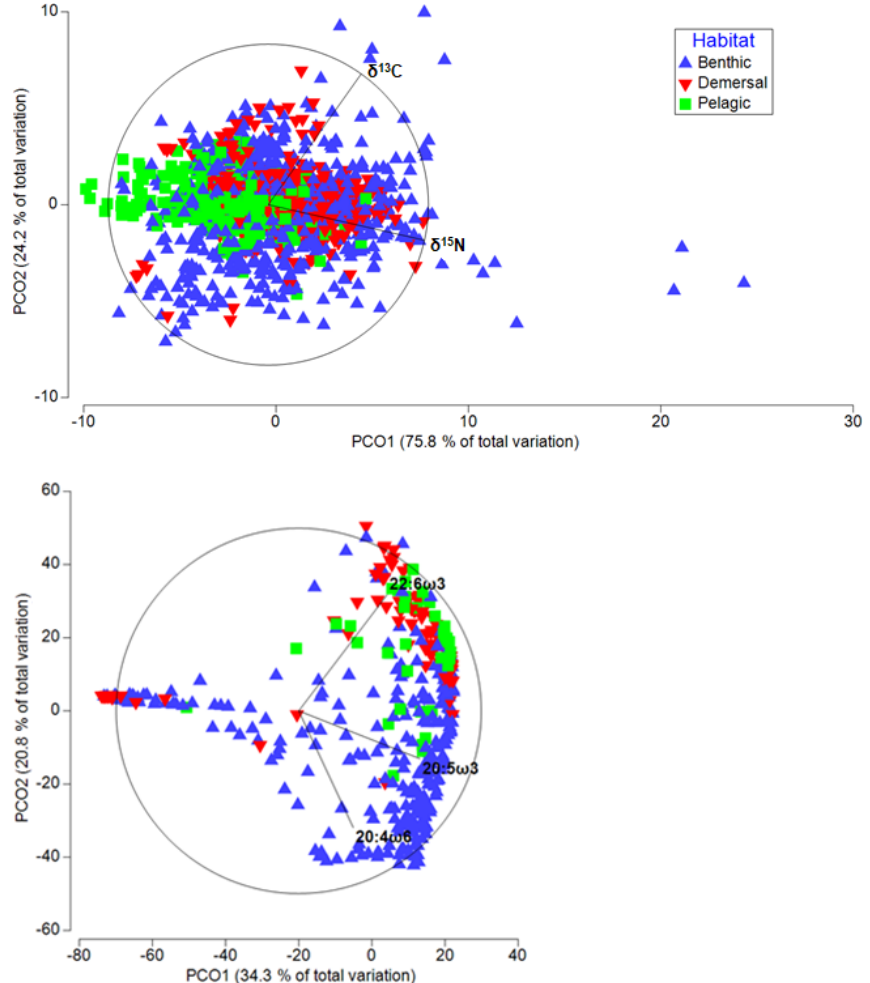
Figure 4. Differences in terms of biochemical compositions among deep-sea animals from various habitats. Principal coordinate analysis plots representing differences in terms of isotopic (above) and essential FA composition (below) of deep-water species. In both cases, the variable “habitat” was one of the most important factors, contributing 12% and 8%, respectively, to the variability in the biochemical composition of the deep-sea